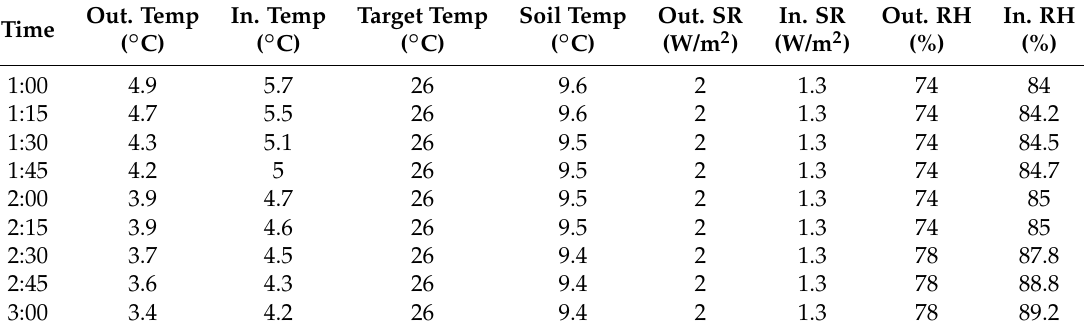
Table 7. Characteristics of the climate on a day in November (Autumn) tomato cultivation in Greenhouse